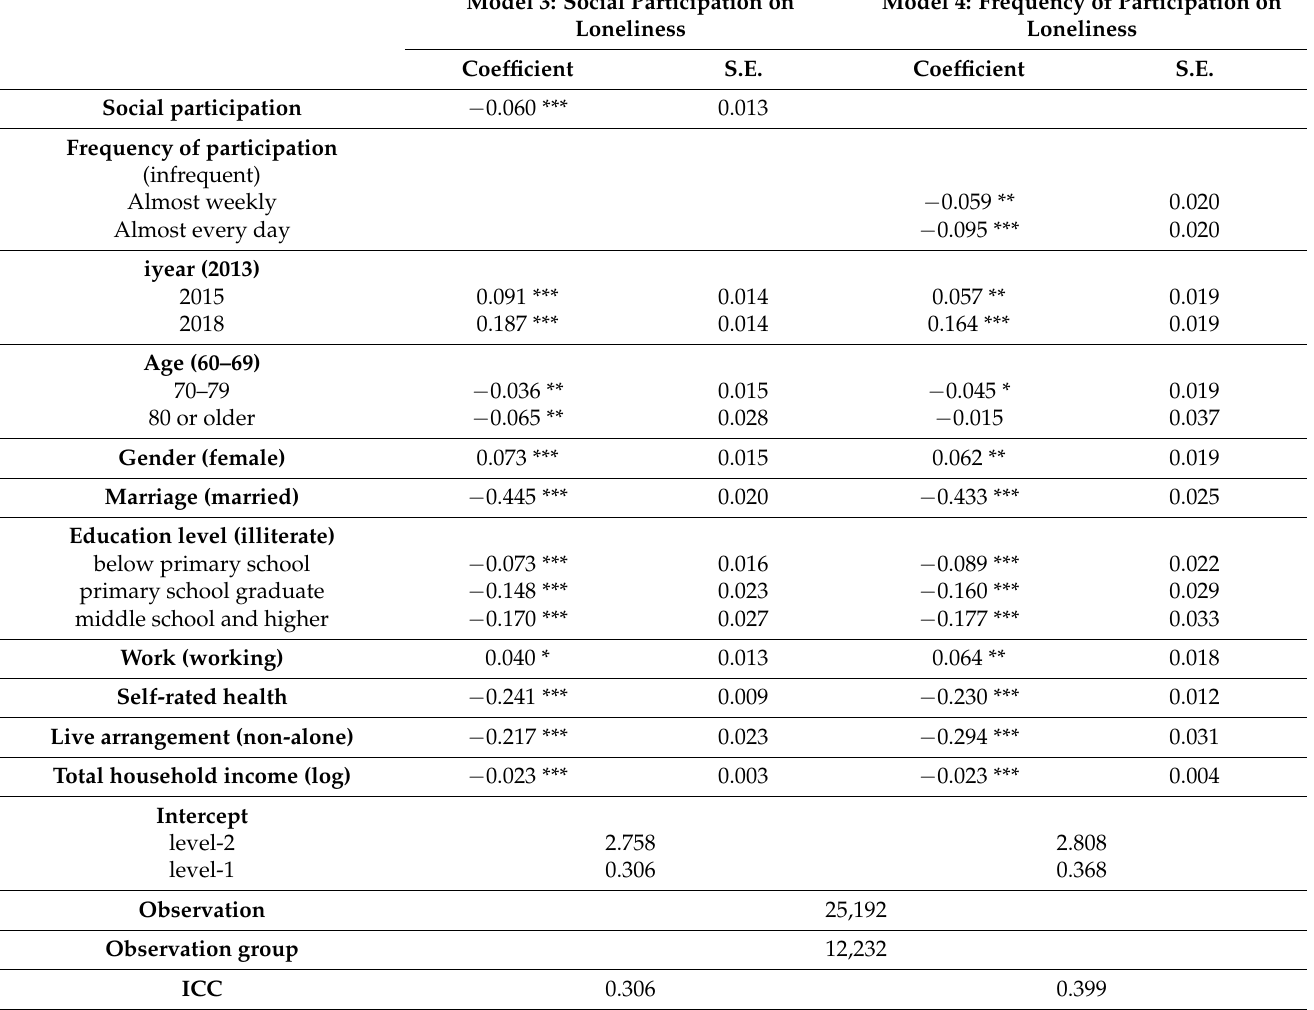
Table 4. Hierarchical linear modeling results of social participation and loneliness. Model 3: Social Participation